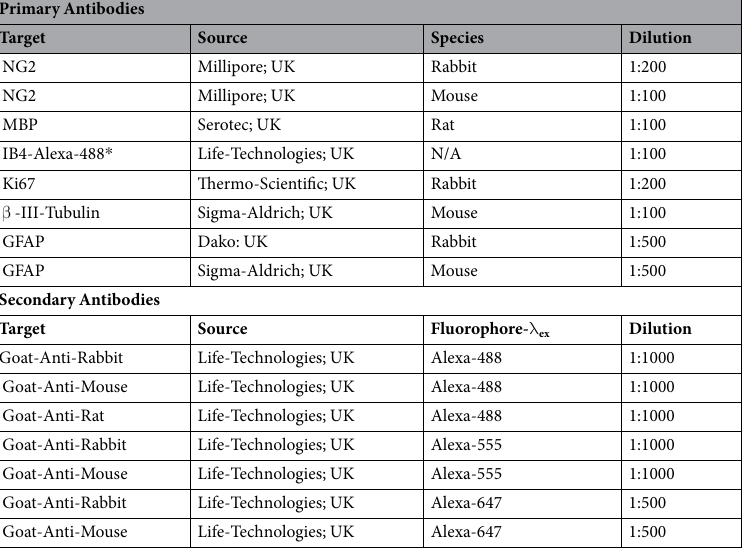
Table 1. * Isolecithin-B4 (IB4) is a lectin conjugated to the Alexa-488 fluorophore, N/A; not applicable, λ ex ; excitation wavelength in